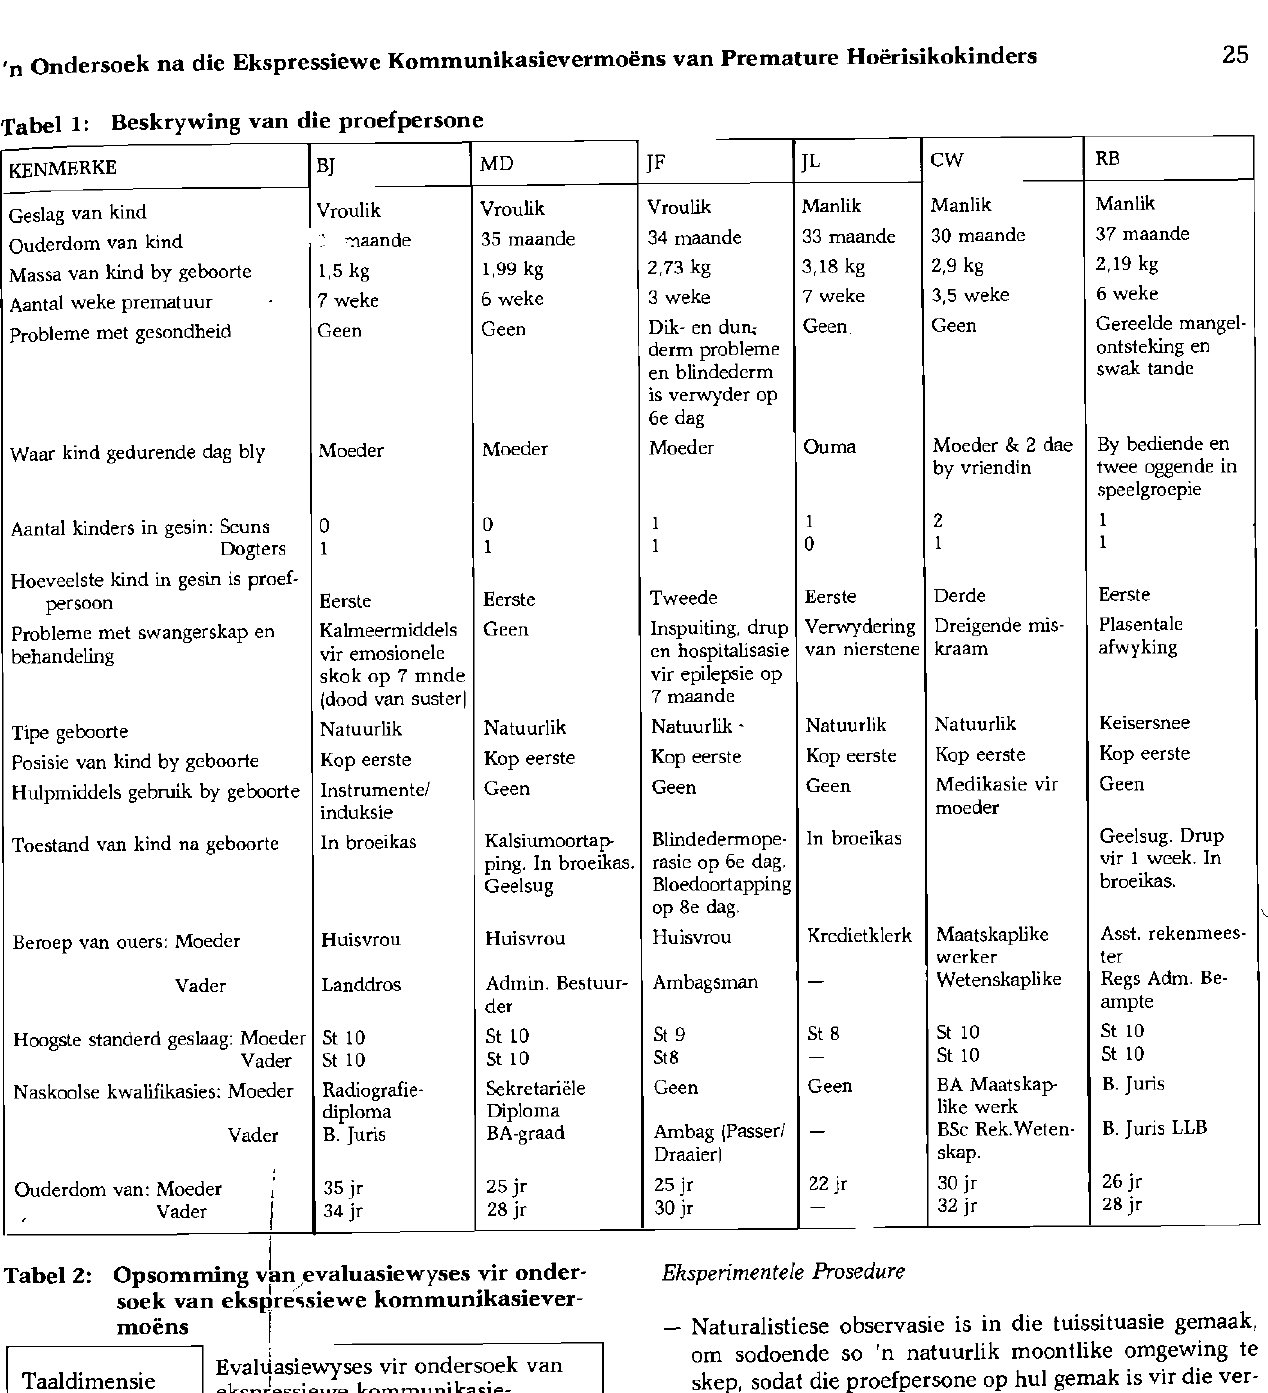
Tabel 2: Opsomming van evaluasiewyses vir